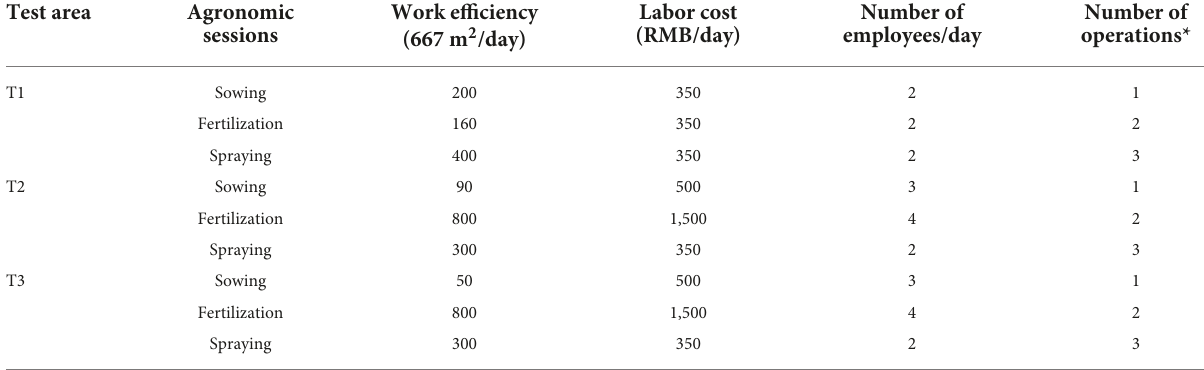
TABLE 4 Efficiency and number of employees of sowing, fertilizing, and application operations in different experimental areas. Test area